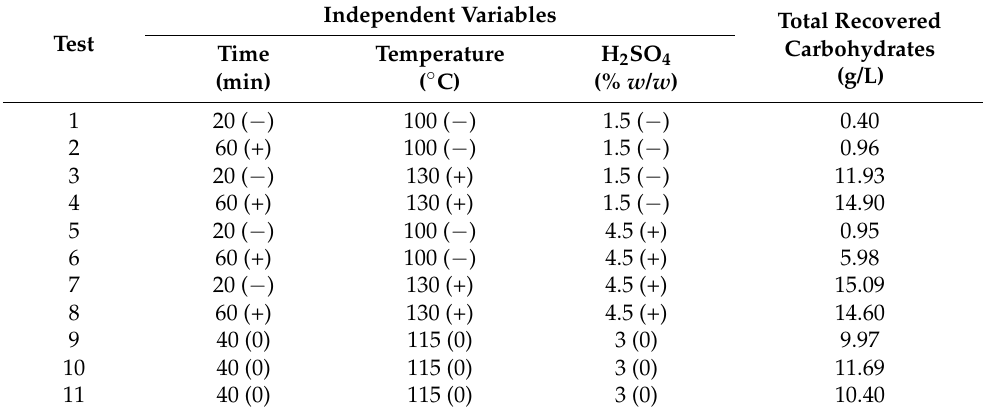
Table 1. Total sugar recovered (g/L) at different conditions of acid pretreatment of eucalyptus